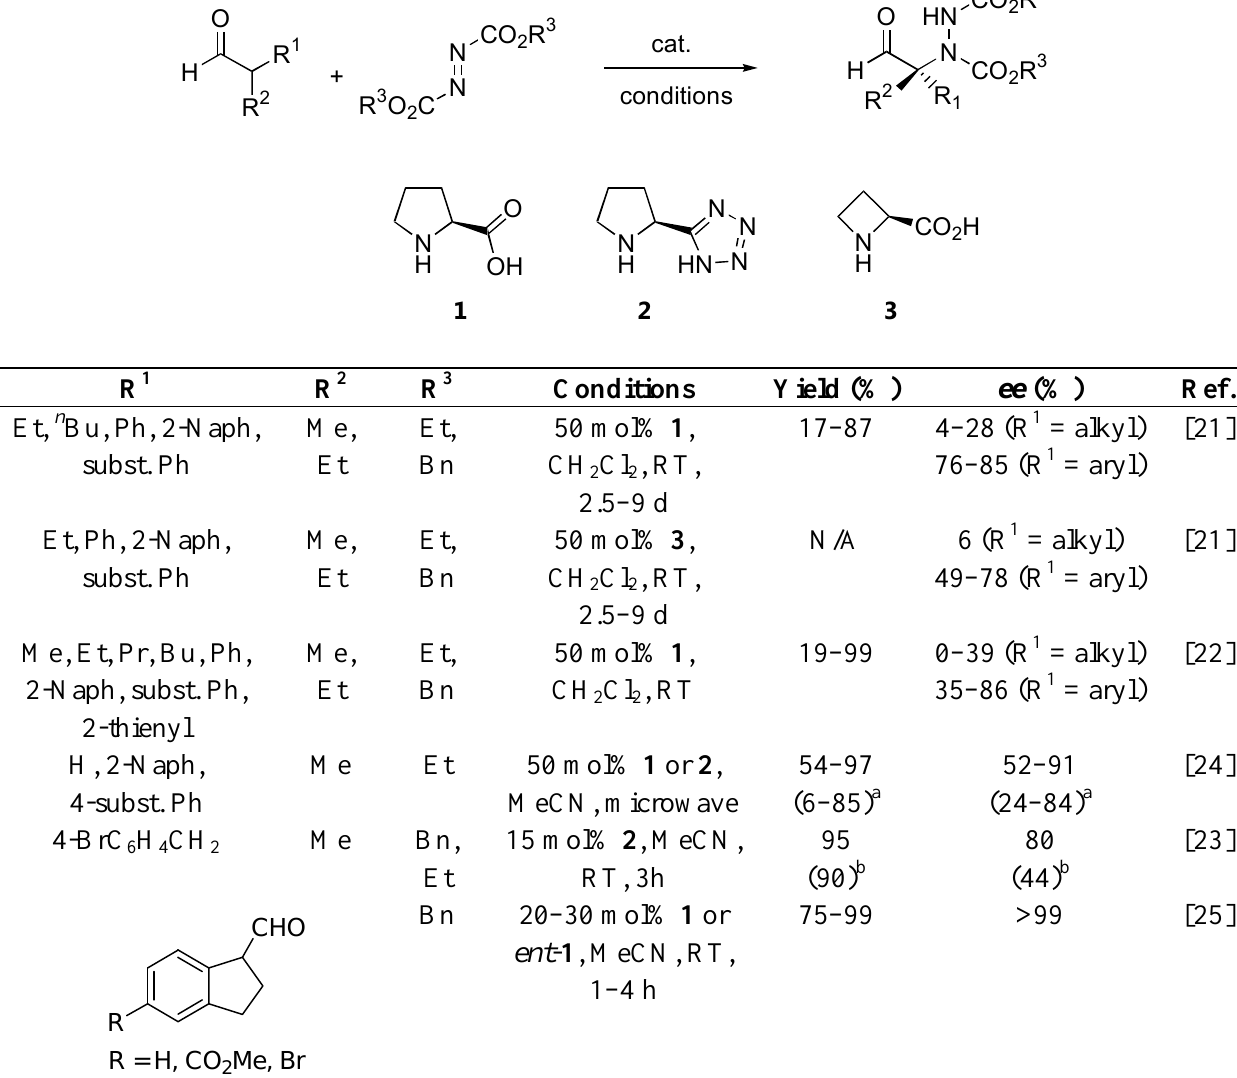
Table 2.  -Amination of  -branched aldehydes catalyzed by proline and